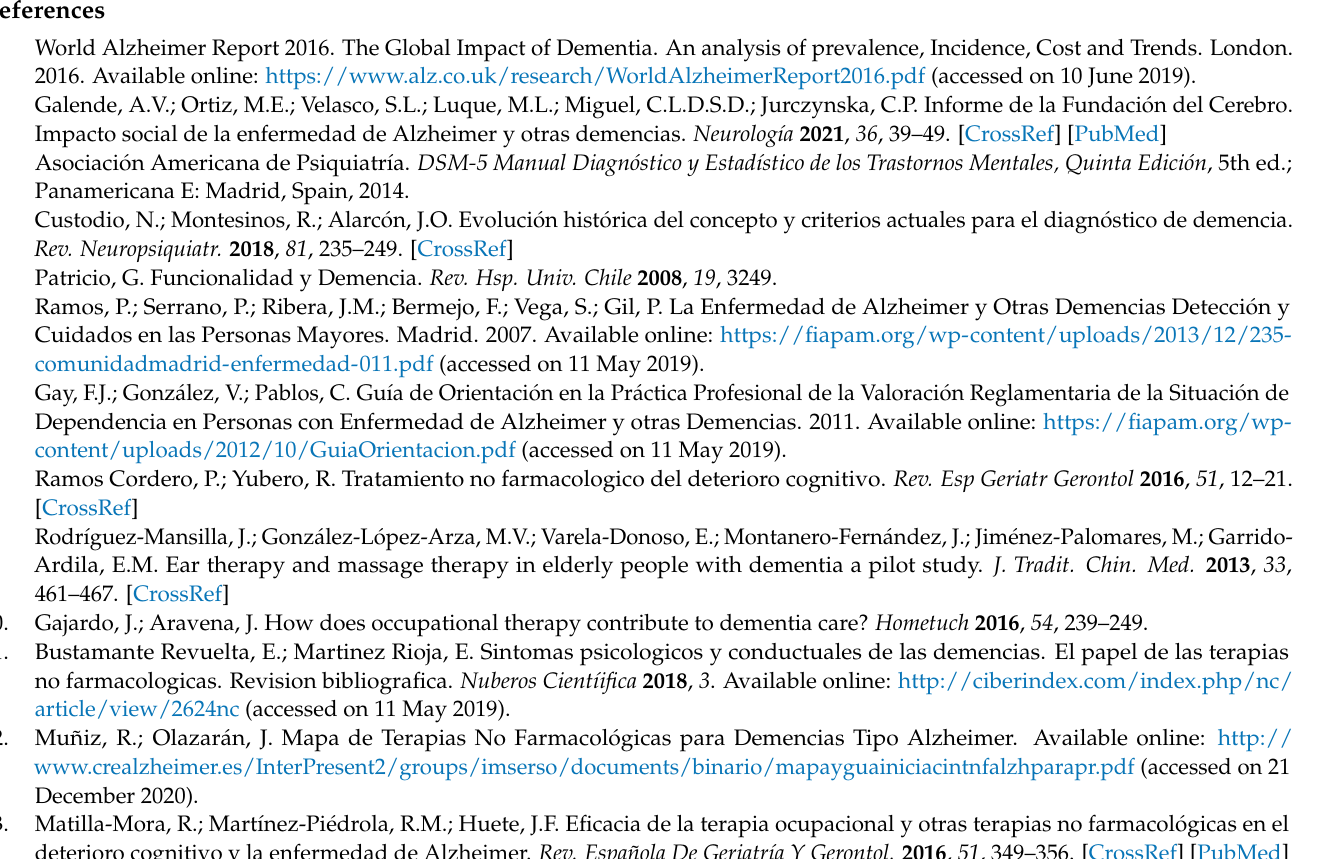
Intervention. Table S2: Comparison of interventions. Table S3: Basic activities of daily living assessed with the Barthel Index that improved after the